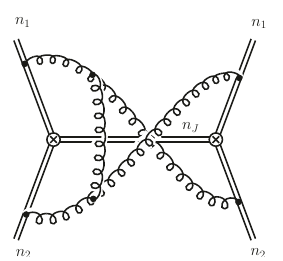
Figure 5. Three-loop Feynman diagram with imaginary part for n 12 > 0